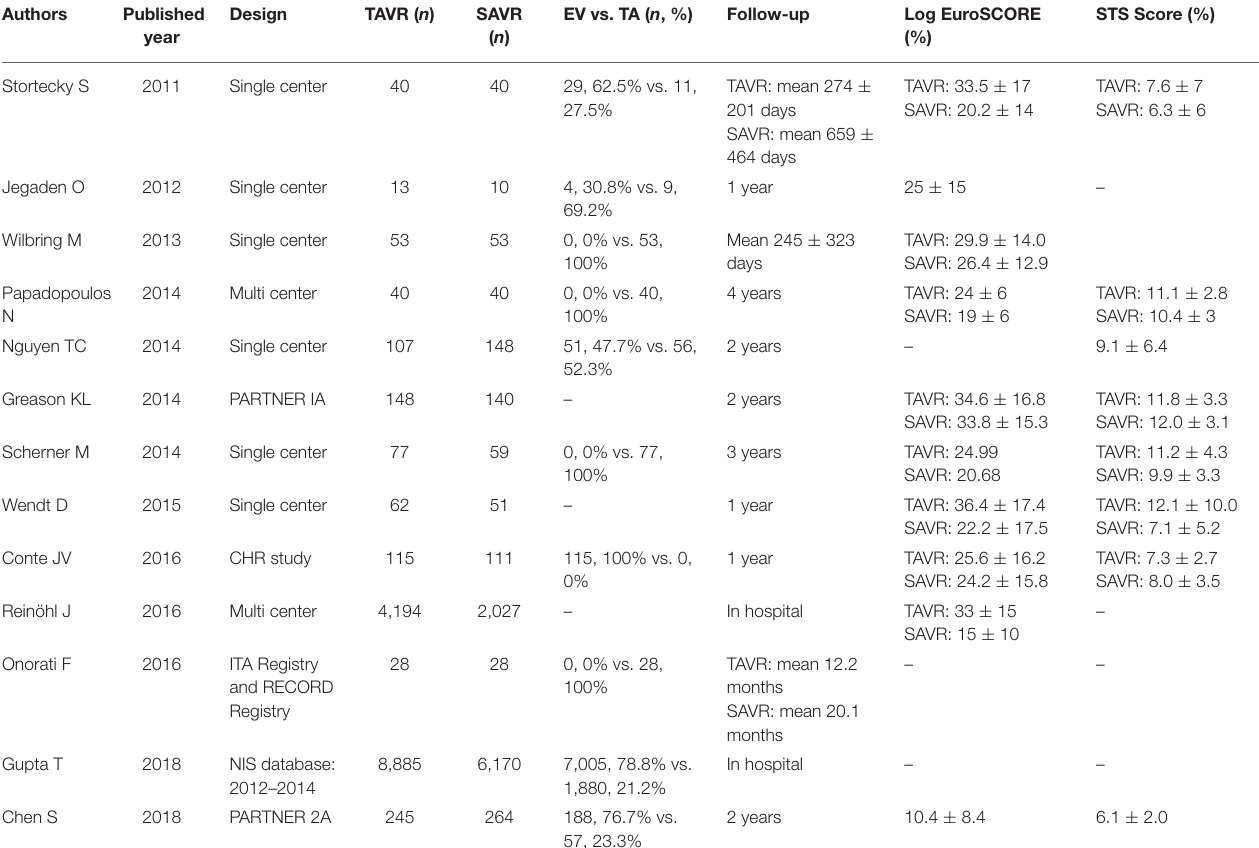
TABLE 1 | Baseline characteristics of the included studies.